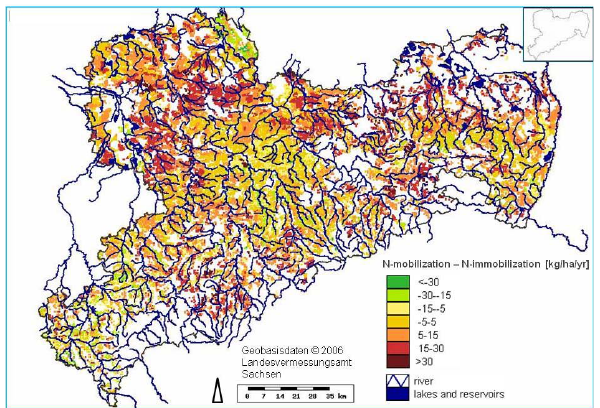
Fig. 5. Results of the function “mobilization – immobilization” from the soil matrix on arable land in Saxony.